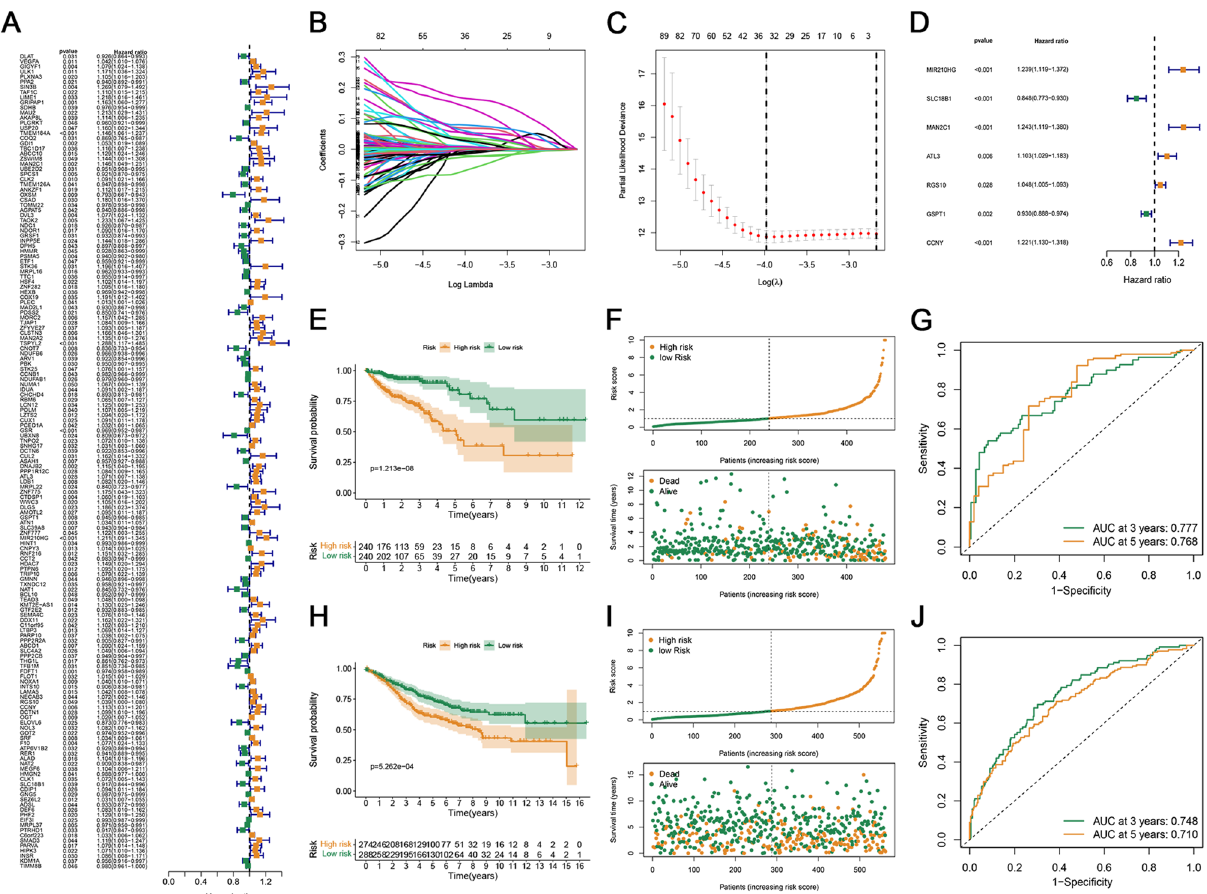
Figure 2. Construction and validation of curoptosis-related signature. ( A ) The prognostic DEGs were selected by the univariate Cox regression analysis. ( B ) LASSO coefficient plot of the prognostic genes in the TCGA cohort. ( C ) The deviance of the cross validation. ( D ) Multivariate Cox regression analysis between CRLs and OS of patients in the TCGA cohort. ( E ) The Kaplan–Meier analysis of OS in the two groups. ( F ) Distribution plot of the risk score and survival status of the patients with CRC. ( G ) ROC curves for predicting the 3- and 5-year survival in the TCGA cohort. ( H ) The comparison of OS between the high- and low-risk score groups in the GEO cohort. ( I ) Distribution plot of the risk score and survival status of the patients with CRC in the GEO cohort. ( J ) ROC curves verified the predictive accuracy of the risk model in the GEO